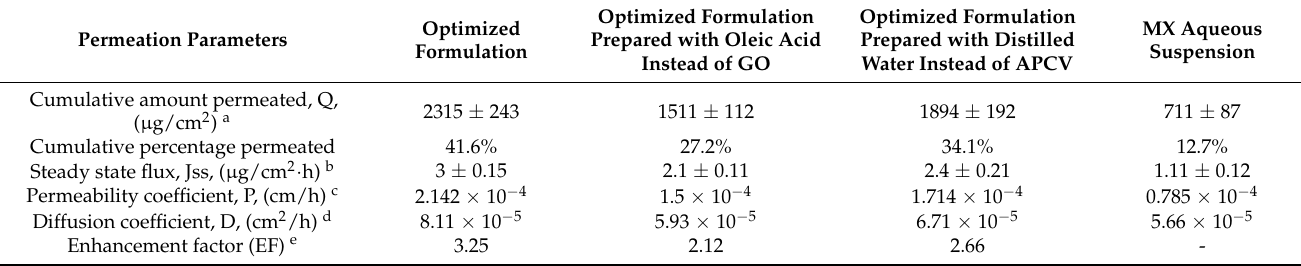
Table 5. Ex vivo permeation results of optimized